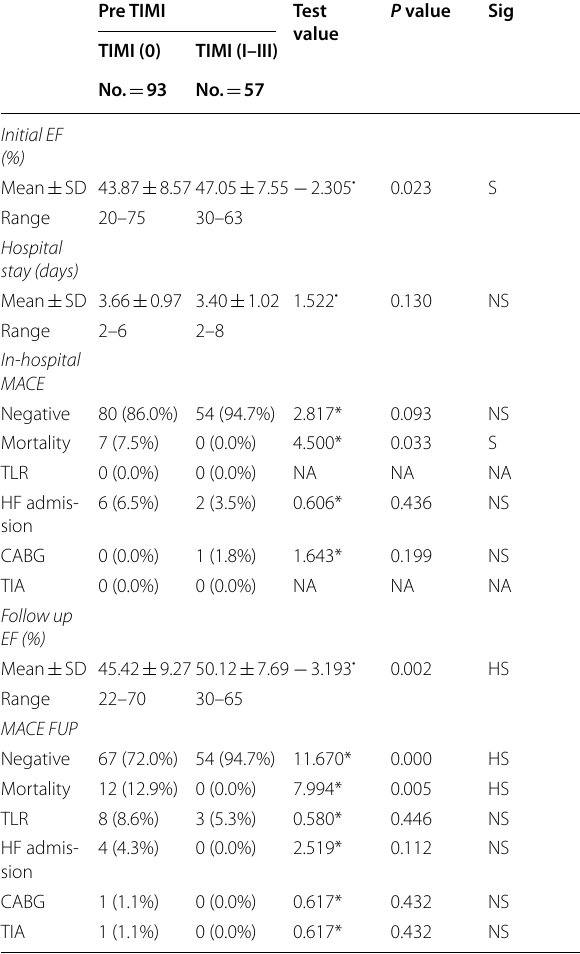
Table 4 Relation between Pre TIMI flow grade and laboratory results / echocardiographic date of the studied patients